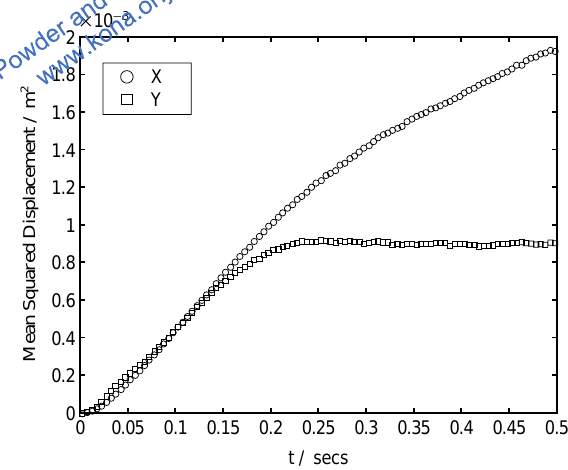
A typical mean squared displacement plot for grains with a starting location of y (cid:4) 22.5 mm. This shows the three main regimes in which the grain exists: (1) short time, the grains are in free motion and the mean squared displace- ment is quadratic with time; (2) intermediate times, the grain undergoes random walk-type behaviour (at which point the grains obey the unbounded diffusion and Smolu- chowski equations); and (3) long times, boundary effects become